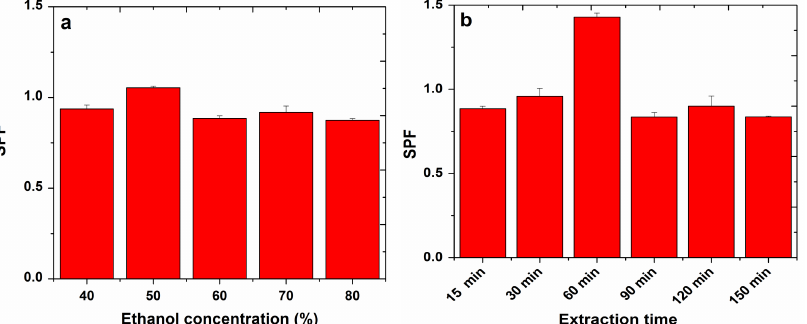
Figure 7. Influence of ethanol concentration ( a ) and extraction time ( b ) on SPF determined for apple extracts, obtained by refluxing.